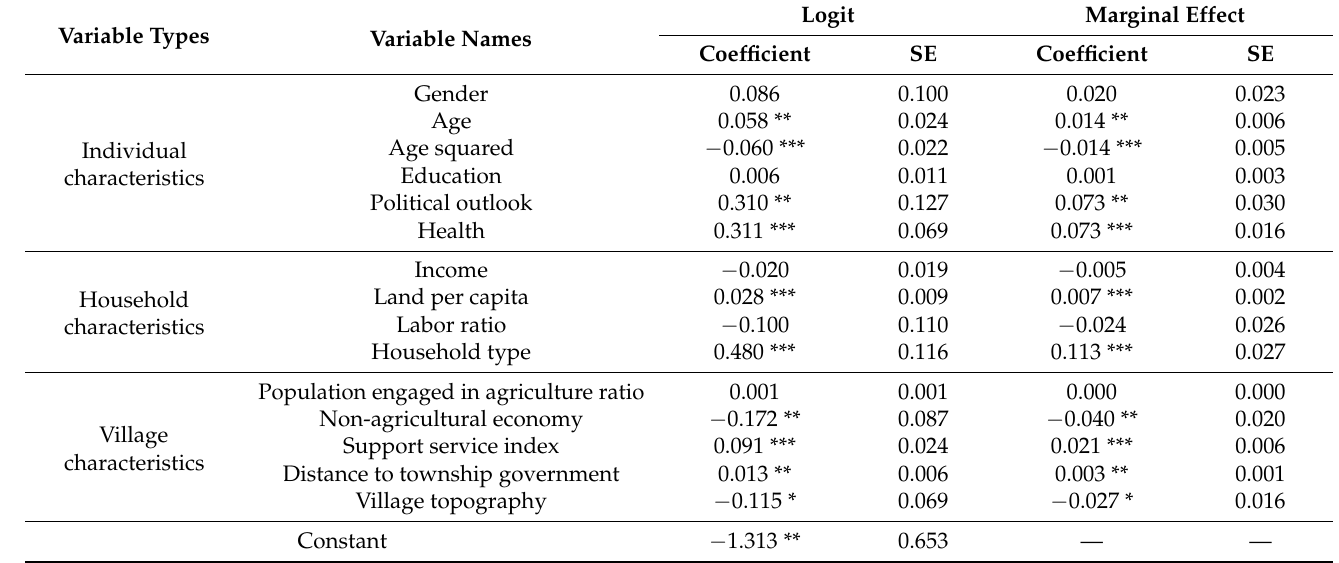
Table 3. Logit model results of factors determining